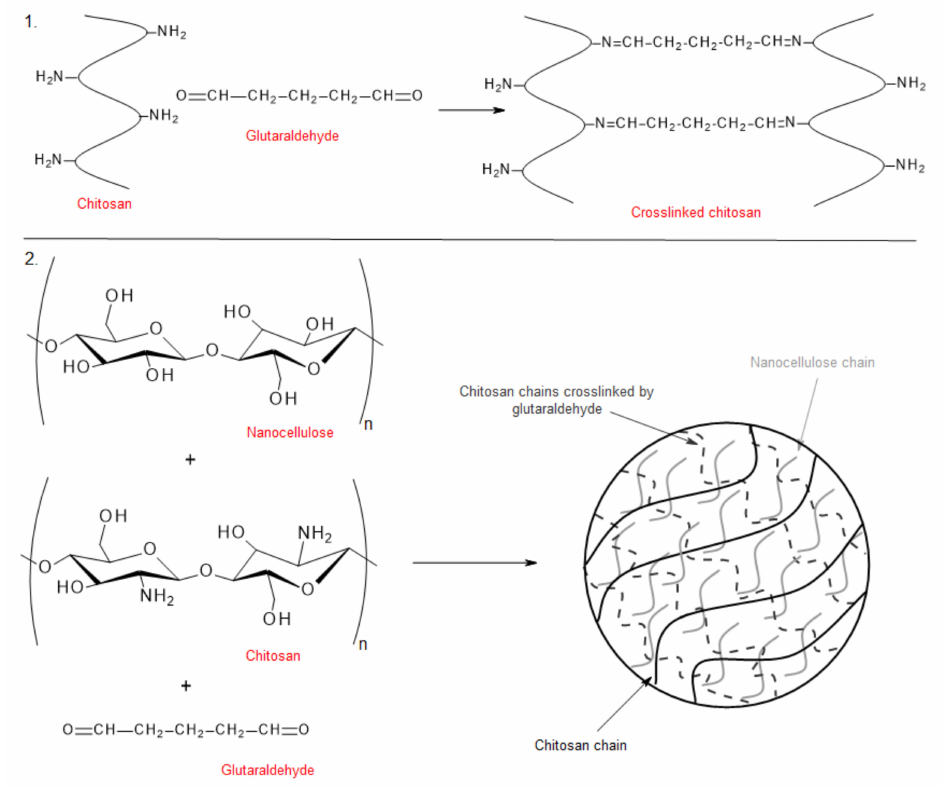
Figure 7. Schematic procedure for the formation of nanocellulose-chitosan hydrogel (summarized by